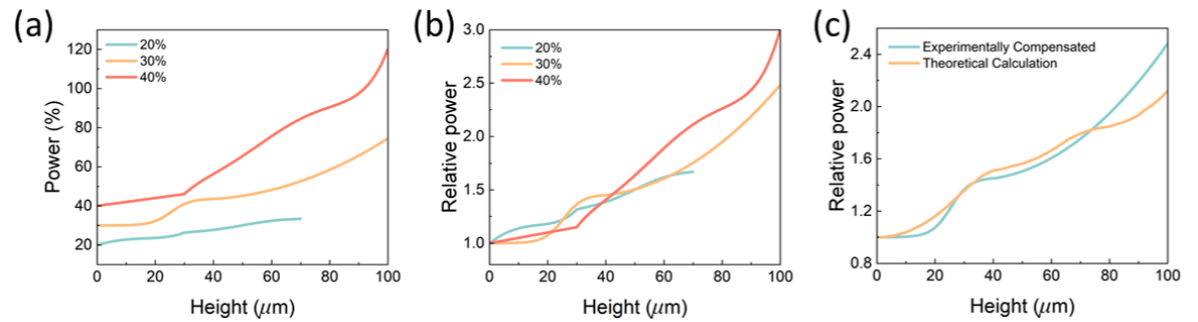
Figure 7. Adjusted fitting curves for lower initial powers. ( a ) Absolute power percentages at different heights after calibration. ( b ) Relative powers to the initial values. ( c ) Comparison of the adjusted compensation and the theoretical